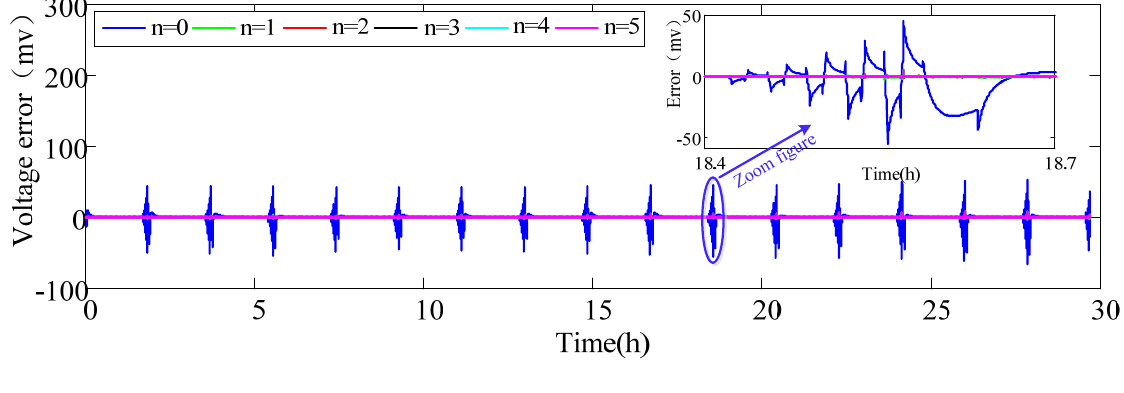
Figure 10. Model voltage prediction error with n =